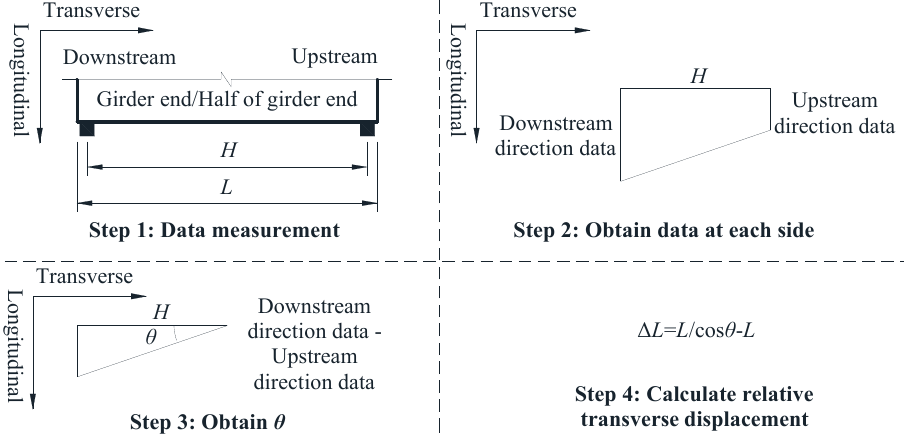
Figure 10. Process used to calculate the relative transverse displacement based on longitudinal displacement data.